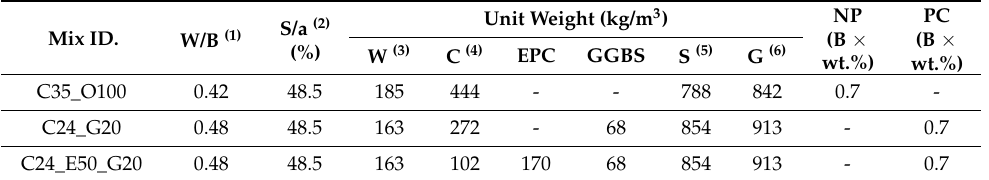
Table 4. Mixing proportions of concrete.